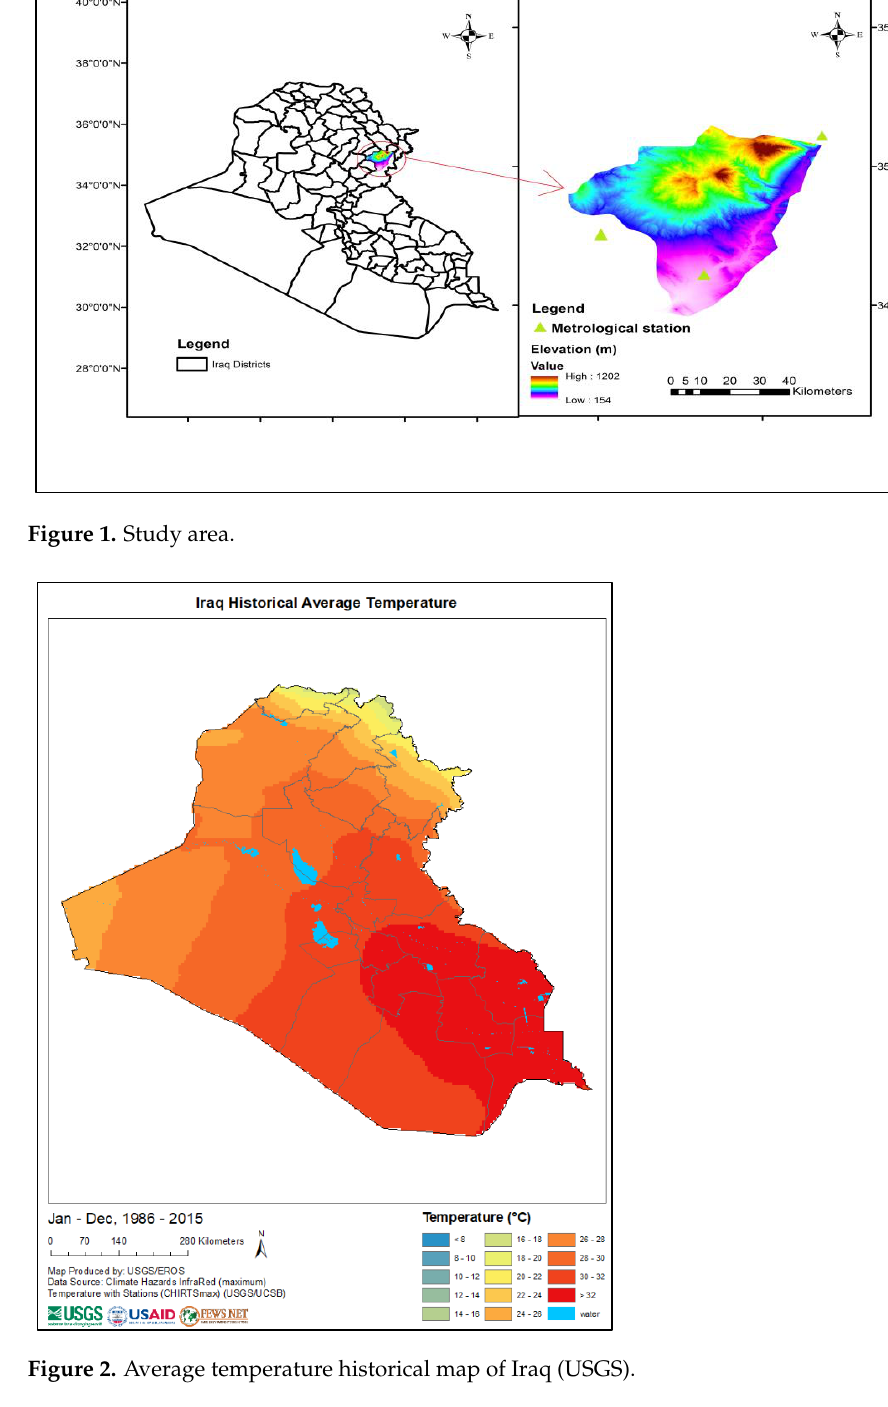
Figure 3. Rainfall amount (mm) at Kalar, Kifre, and Darbandikhan Stations (Directorate of Meteor- ology and Seismology of Sulaymaniyah). 2.2. Methodology Proper site selection for RWH areas can be divided into five steps as follows: Data collection. Selection of a set of criteria. Classification of suitability and weight of each criterion. Deciding to use an MCA process to overlay the thematic maps and GIS analysis to produce a suitability map. Selection of the most suitable sites for RWH.